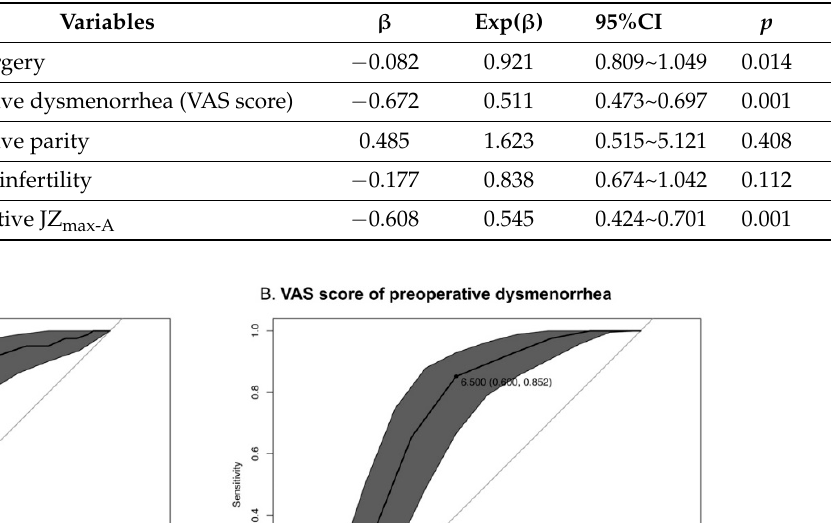
Table 3. Multivariate analysis of cofounding factors for postoperative pregnancy.